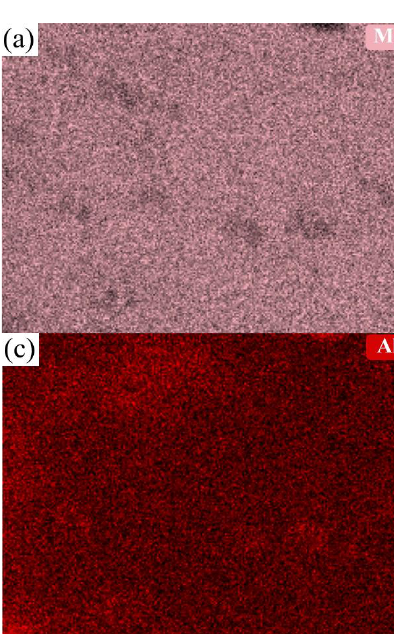
Figure 3. X-ray maps of ( a ) Mg, ( b ) Ti, ( c ) Al, and ( d ) V in Figure 2b.